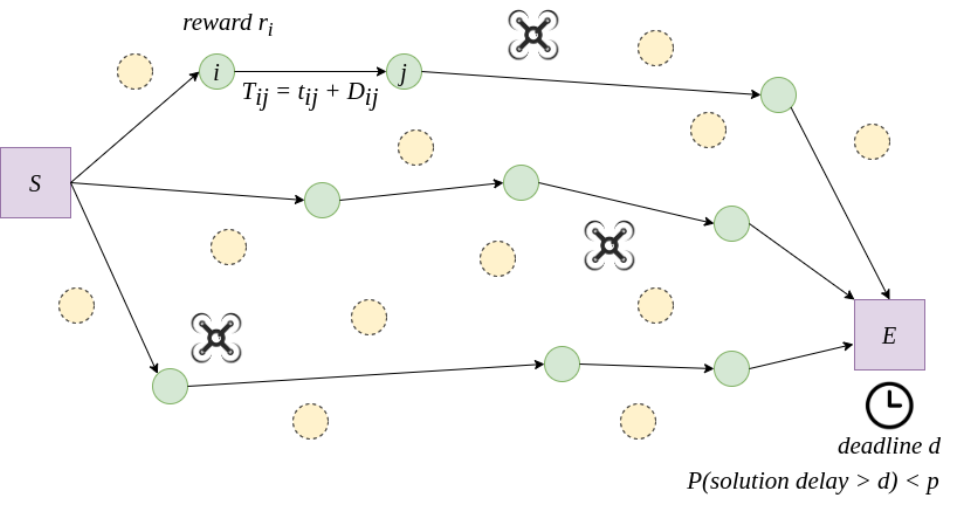
Figure 1. A team orienteering problem with probabilistic